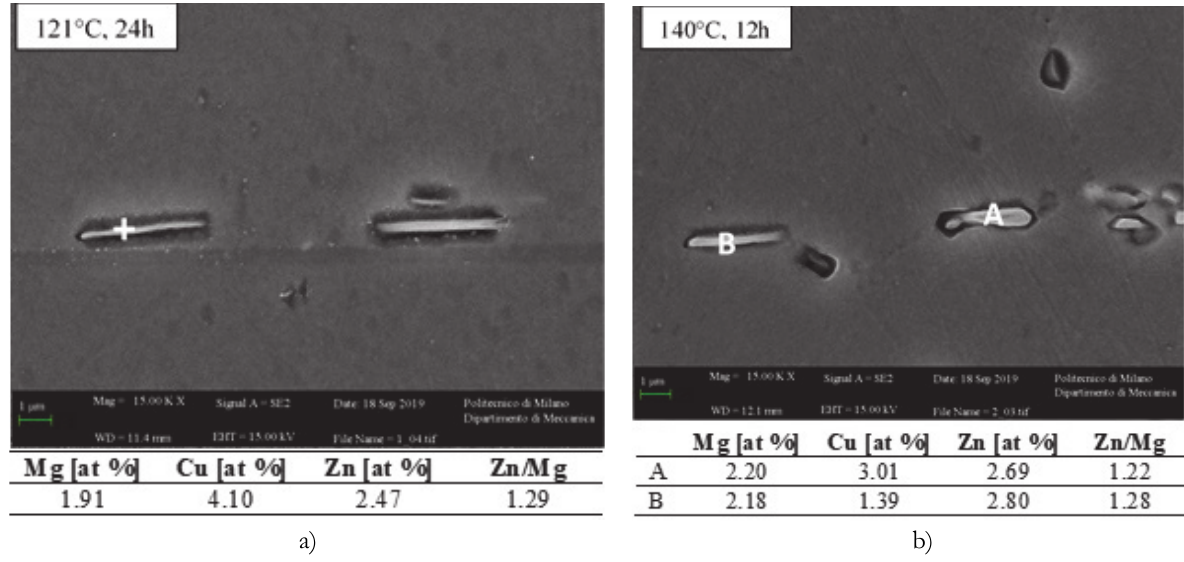
Figure 4: Zn-Cu-Mg rich precipitates observed after different ageing